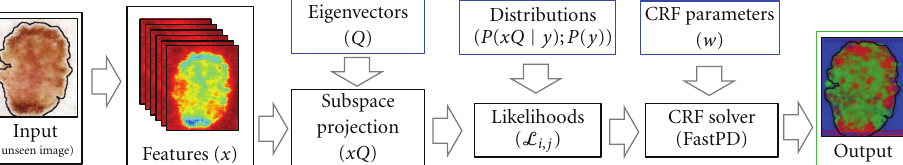
Figure 5: The testing phase of our CRF model. After the likelihoods are computed, we use the CRF parameters from the training phase, and the software FastPD to generate label